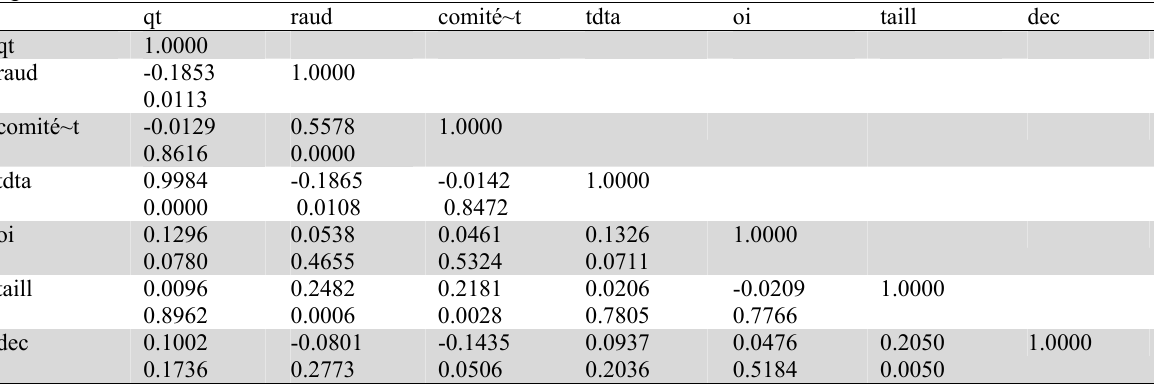
Spearman correlation matrix